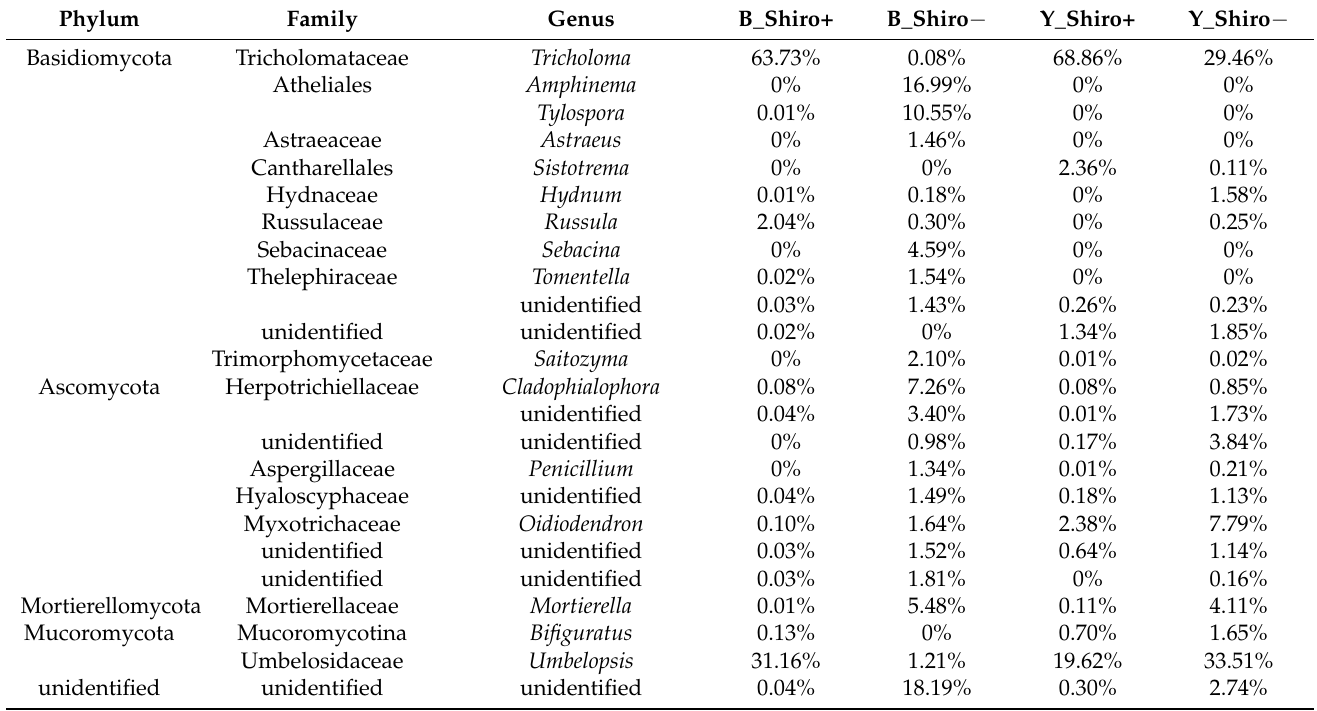
Table 5. List of fungal genera inhabiting the Tricholoma matsutake production (shiro+) and nonproduction (shiro − ) soils of Bonghwa and Yangyang sampling sites. The fungal genera present more than 1% of at least one sample among the four soil samples.